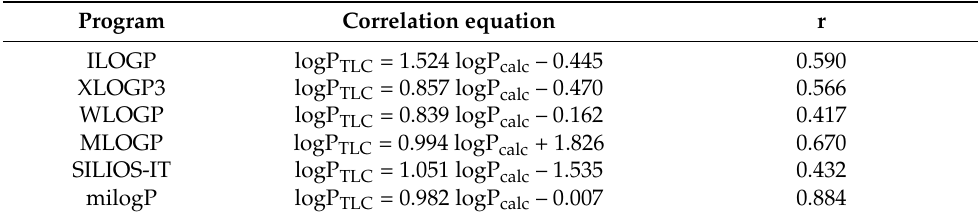
Table 4. Correlation equations for experimental (logP TLC ) and theoretical (logP calc ) lipophilicity for compounds 1 – 24